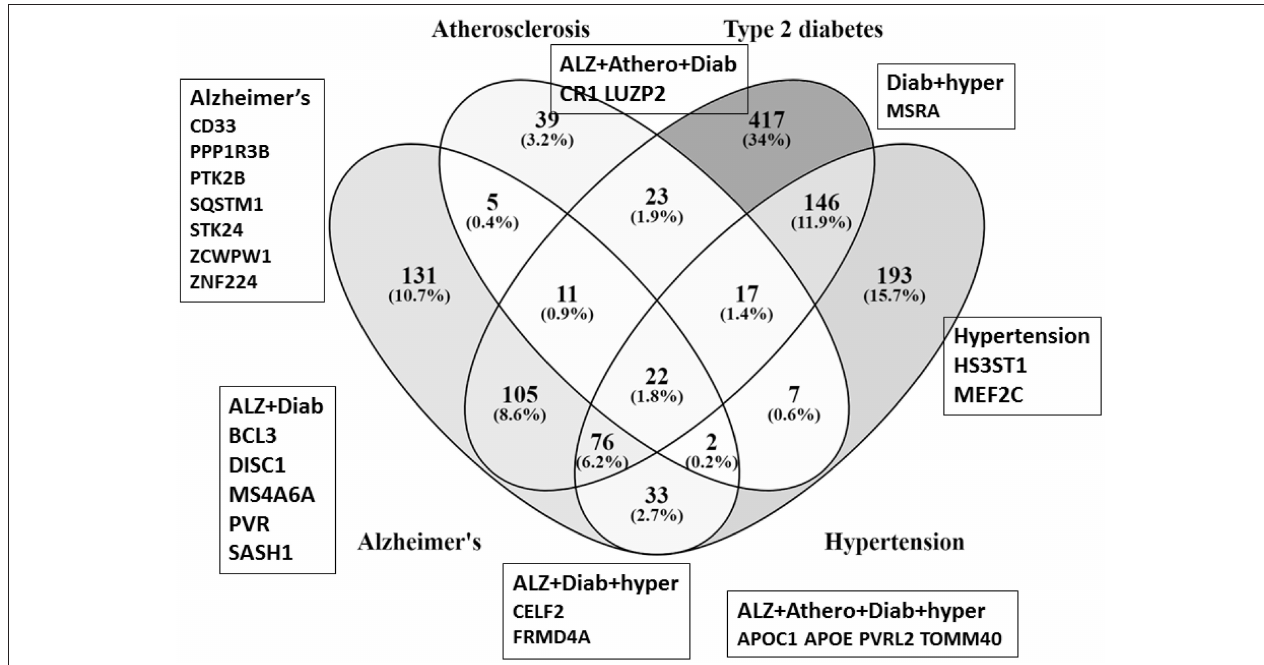
FIGURE 1 | Venn diagram shows the number of susceptibility genes (GWASdb) and their percentage occurrence within the P. gingivalis /host interactome that are common or specific to various combinations of atherosclerosis (Athero), type 2 diabetes (Diab), hypertension (hyper) and Alzheimer’s (Alz), The Venn diagram is for data from GWASdb. The genes in boxes refer to GWAS genes from the more stringent NCBI-EBI data that are also part of the P. gingivalis /host interactome. The percentages are those of the sum of the interactome/susceptibility gene overlaps for all diseases represented in the figure (atherosclerosis + type 2 diabetes + hypertension + Alzheimer’s gene/interactome